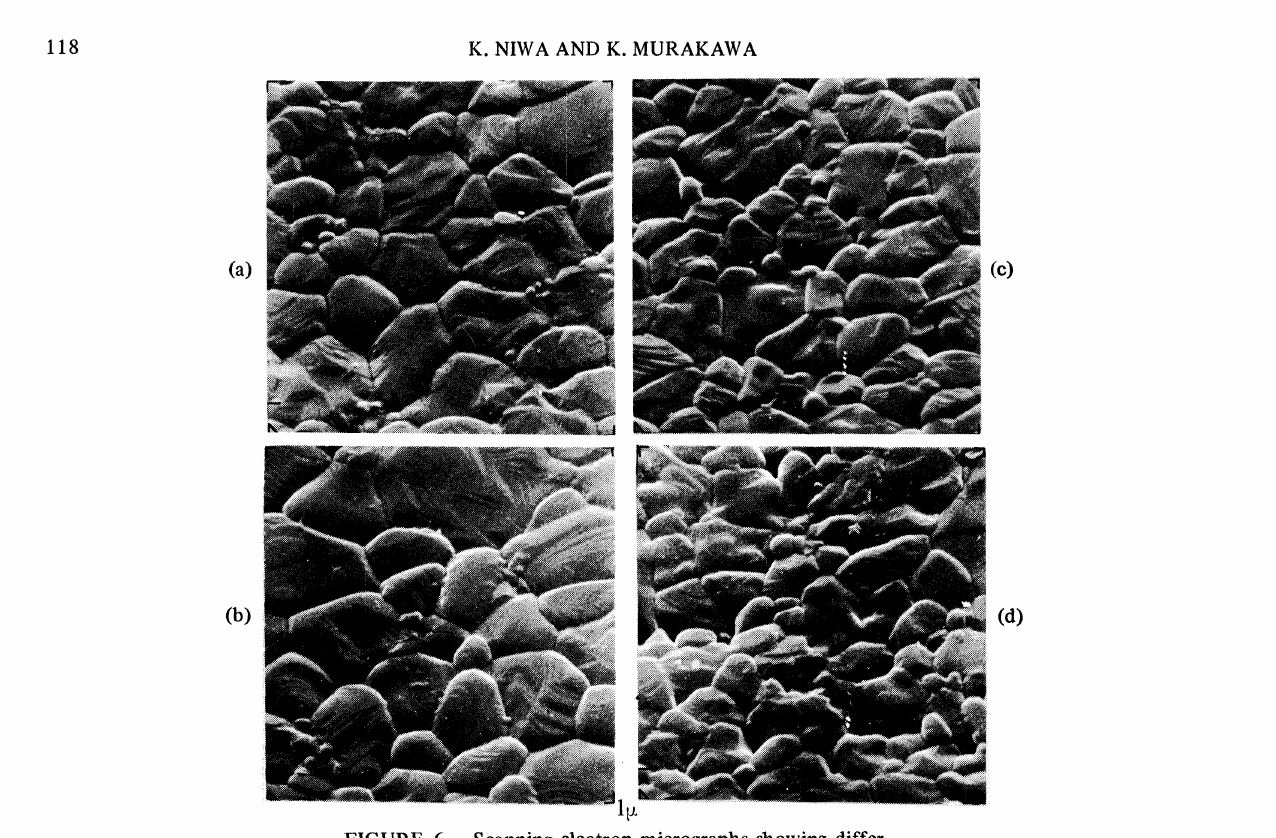
FIGURE 6 Scanning electron micrographs showing differ- ence in microstructure of substrates fired at 1600C, 2 hours in hydrogen, 6(a) Gloss 75, 6(b) Gloss 65,6(c) Gloss 58, 6(d) Gloss 5 2.